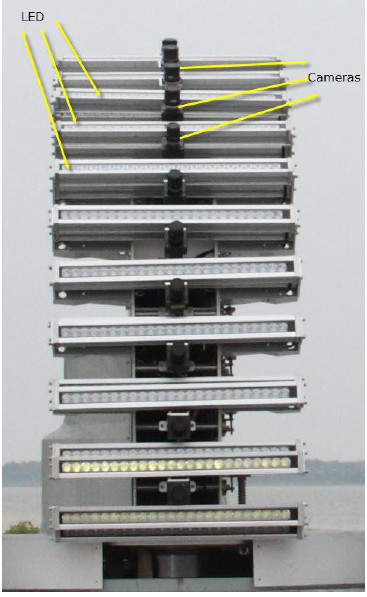
Figure 2 Close-up of Camera and Reflector